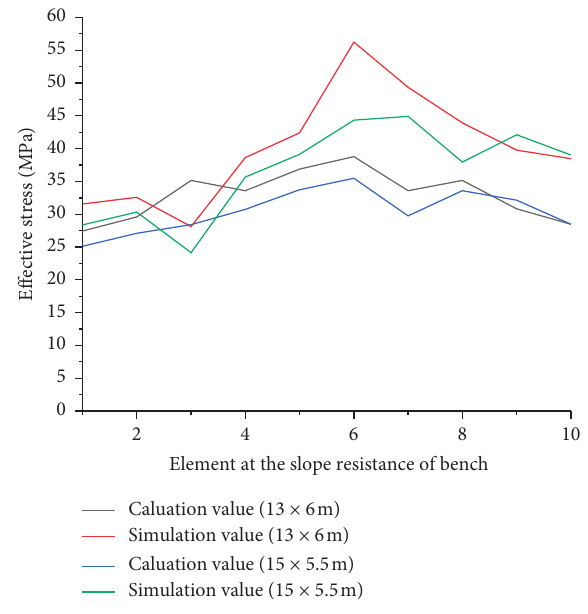
Figure 15: Effective stress of the section at the slope resistance of